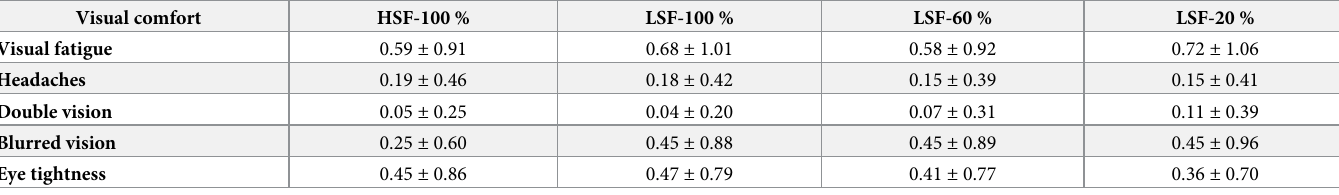
Table 6. Mean visual comfort scores as a function of the binocular background